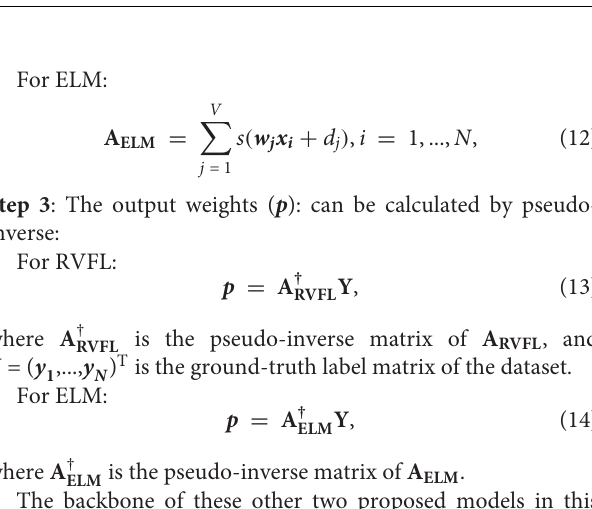
FIGURE 5 | The structures of (A) RVFL and (B) ELM.